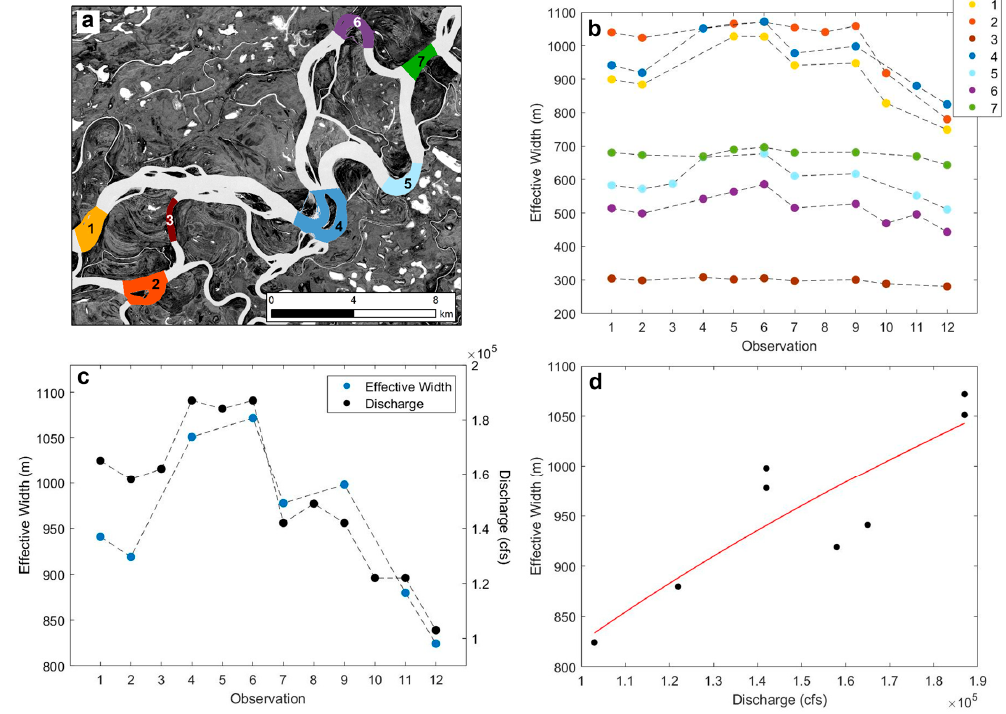
Figure 6. ( a ) Map of seven river reach segments and ( b ) time series of corresponding river effective width. Color and number of time series in ( a ) corresponds to color and number of reach in ( b ); ( c ) Time series of effective width for river reach #4 and corresponding Yukon River discharge at Eagle and ( d ) scatter between effective width and Yukon River discharge (Q) at Eagle The equation of the best fit curve in panel ( d ) (shown in red) is W e = 10.9 Q 0.38 (R 2 = 0.75).